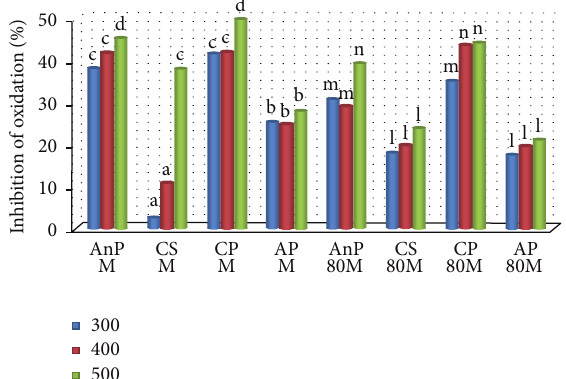
Figure 3: Inhibition of lipid oxidation in brain homogenate by different plant extracts. AnP: Andrographis paniculata ; CS: Costus speciosus ; CP: Canthium parviflorum ; AP: Abrus precatorius ; M: methanol; 80M: 80% methanol; a, b, c, . . . represent significance of methanol extracts; l, m, n, ... represent significance of 80% methanol extracts ( 𝑝 ≤ 0.05 ). Values are the mean of triplicates ( 𝑛 = 3 ).